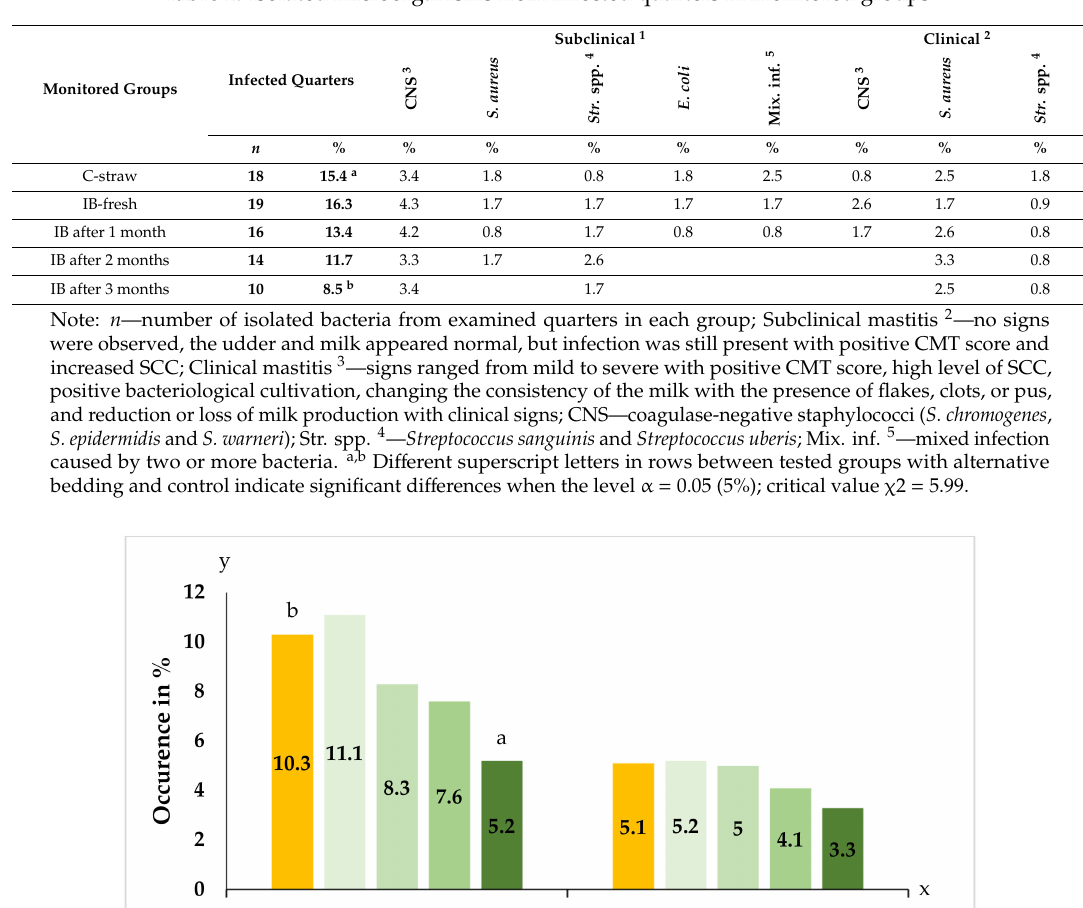
Table 2. Isolated microorganisms from infected quarters in monitored groups.